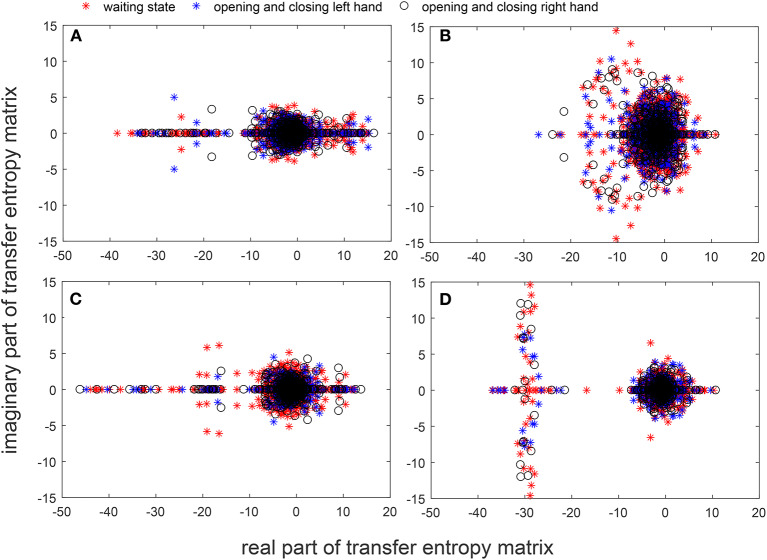
Spectra graphs of transfer entropy matrix. The horizontal axis shows the real part of the transfer entropy matrix, while the vertical axis represents the imaginary part of the transfer entropy matrix. The red star, blue star, and black circle indicate waiting state, opening, and closing the left hand, and opening and closing right hand, respectively. (A) 3 events of participant 1 (B) 3 events of participant 2 (C) 3 events of participant 3 (D) 3 events of participant 4.